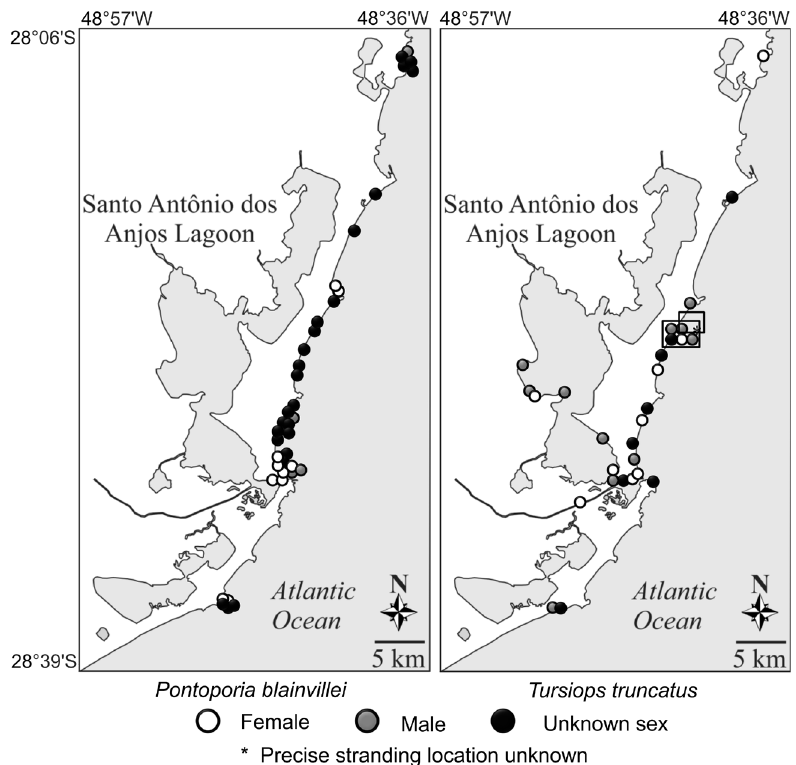
Figure 8. Spatial distribution of strandings of Pontoporia blainvillei and Tursiops truncatus in the south region from 1983 to